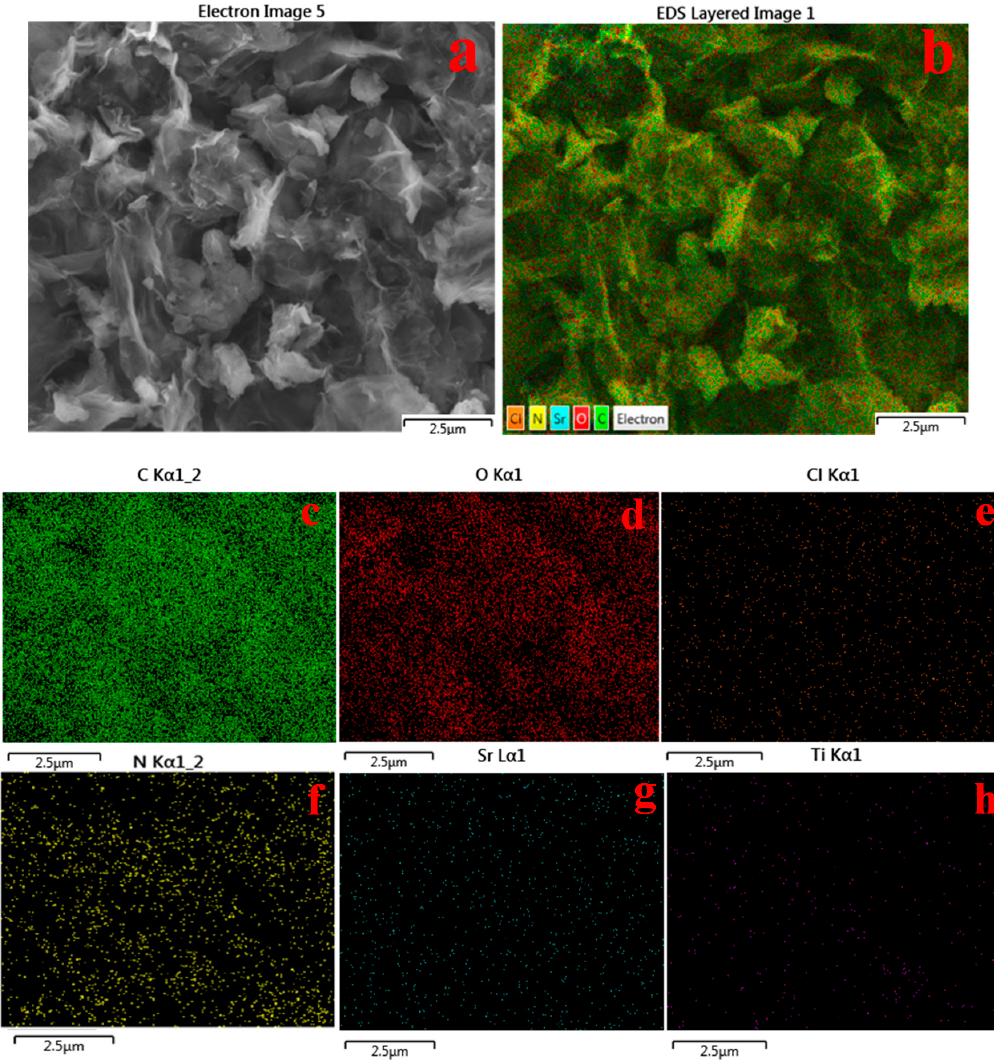
Figure 2. ( a ) FESEM image and ( b ) EDX elemental mapping of GOPSr-2 nanocomposite on a Si